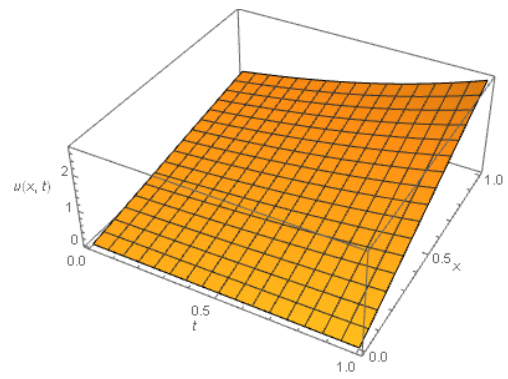
Figure 2:3D approximate Solution of Figure 1:3D exact Solution of example3 Figure 12. 3D approximate Solution of Example 3 with α = Figure 3:3D Solutions of example3 with di⁄erent Figure4: Absolute error of example3 at example3 with (cid:11) = 1 with (cid:11) = 1